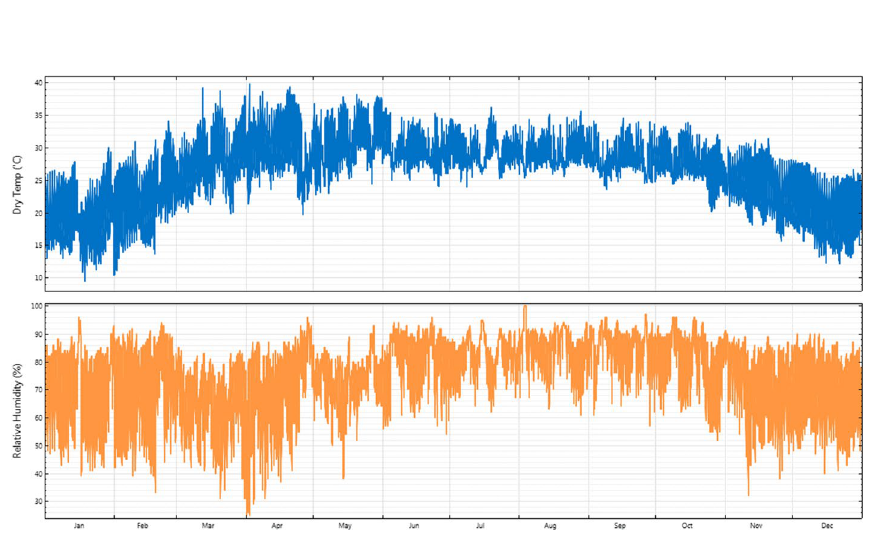
Fig. 5 Dry bulb temperature and relative humidity of